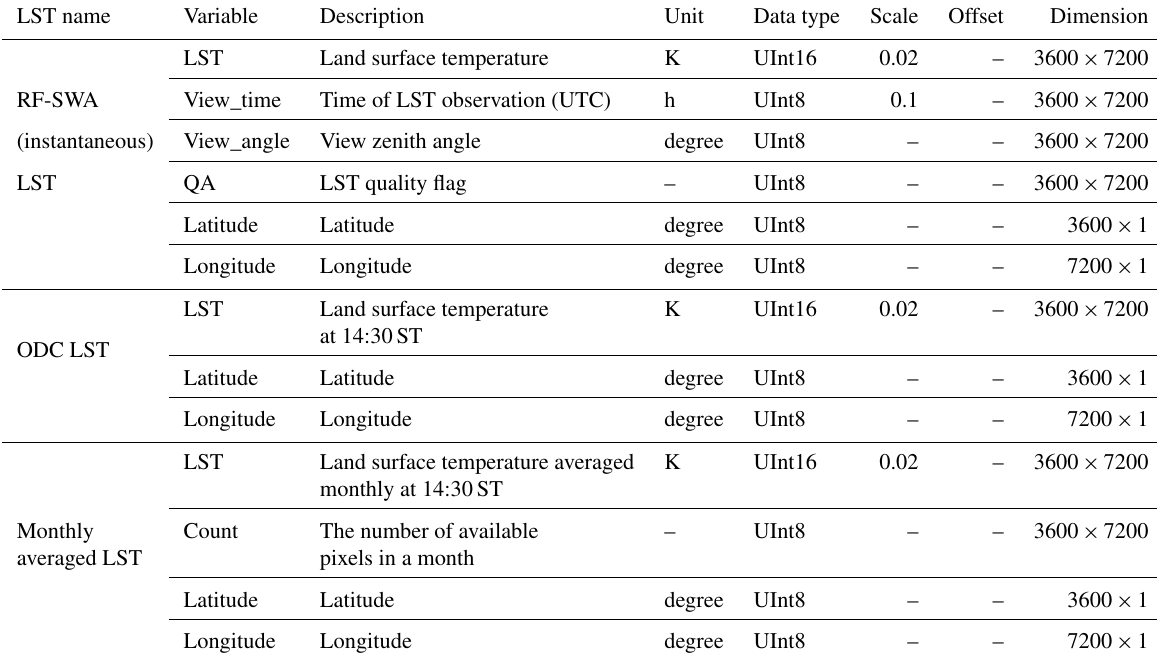
Table 8. Variables in the LST